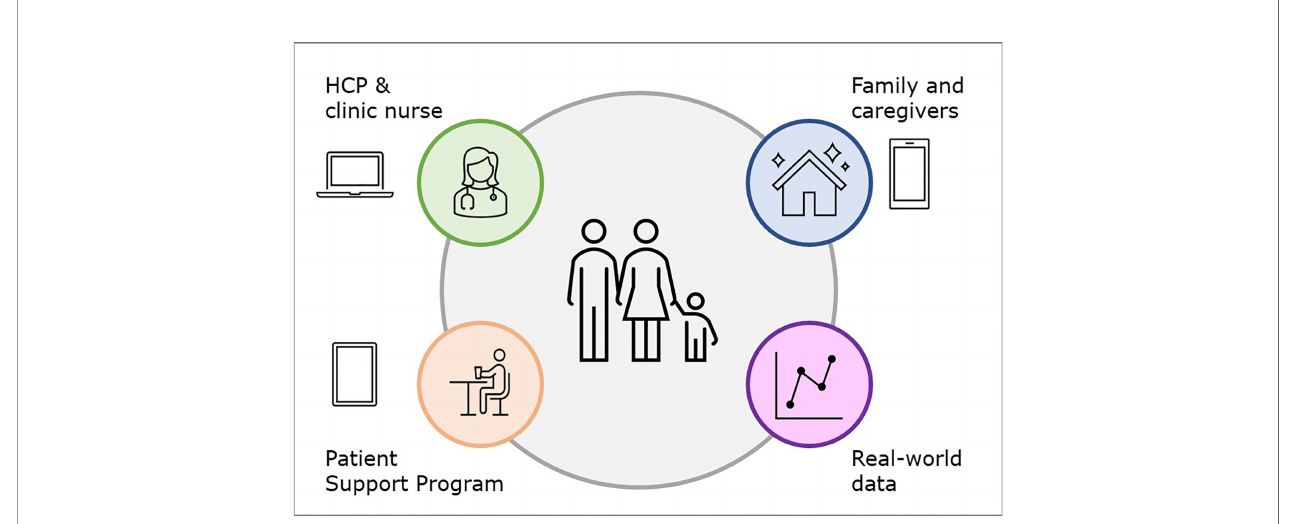
FIGURE 1 | Growth hormone digital health ecosystem.